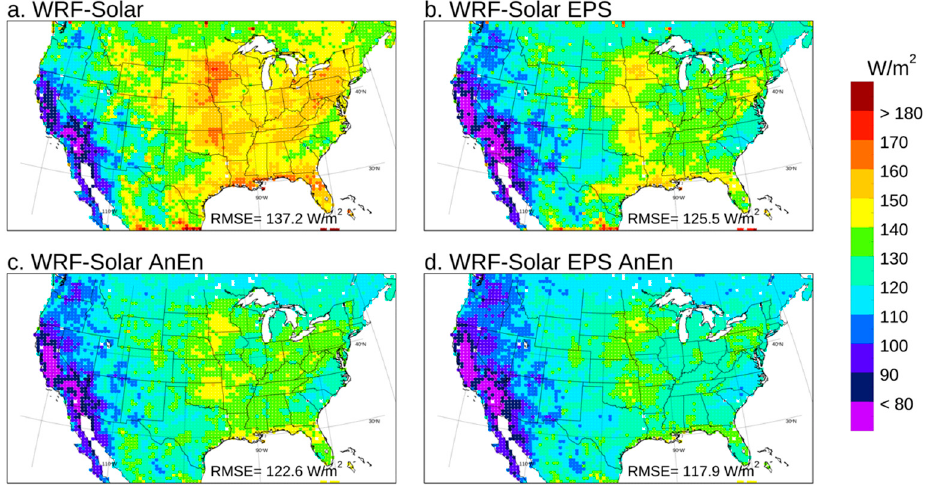
Figure 3. Root mean squared error (RMSE) computed for GHI over the year 2018 for the forecast lead times from +24 to +48 h. The value in the legend at the bottom of each panel indicates the RMSE computed by pooling all the grid points and lead times together.